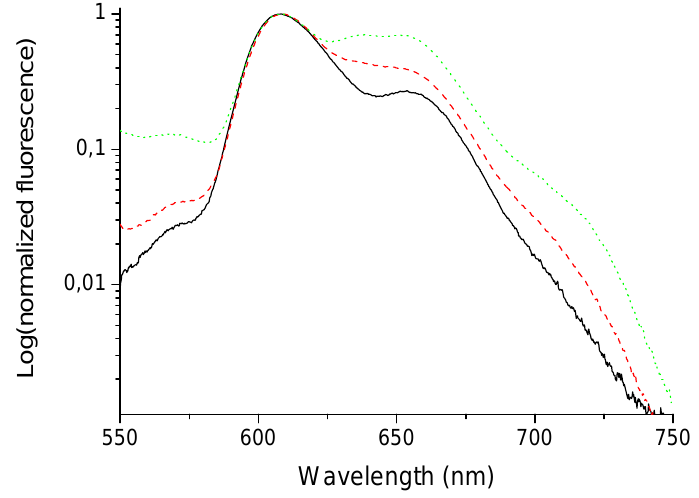
Figure 6. Emission spectra (logarithmic scale) of Acetonide-G0-prop-TPPZn (solid/black), Acetonide-G4-prop-TPPZn (dashed/red), and Acetonide-G5-prop-TPPZn (dotted/green). Concentration 0.010 mM (THF); excitation wavelenth 403 nm. Slits 5 and 10 nm for excitation and emission,